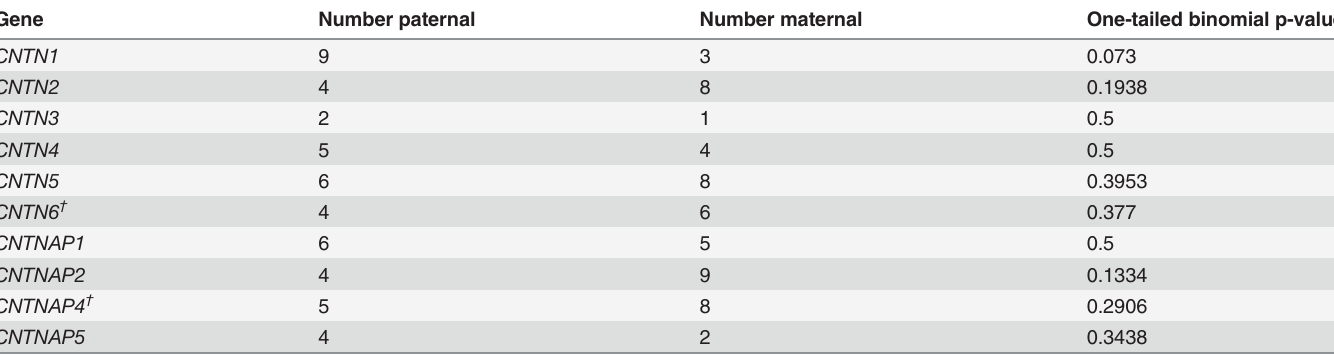
Table 4. Inheritance of mutations predicted deleterious * by SIFT-or-PolyPhen2.